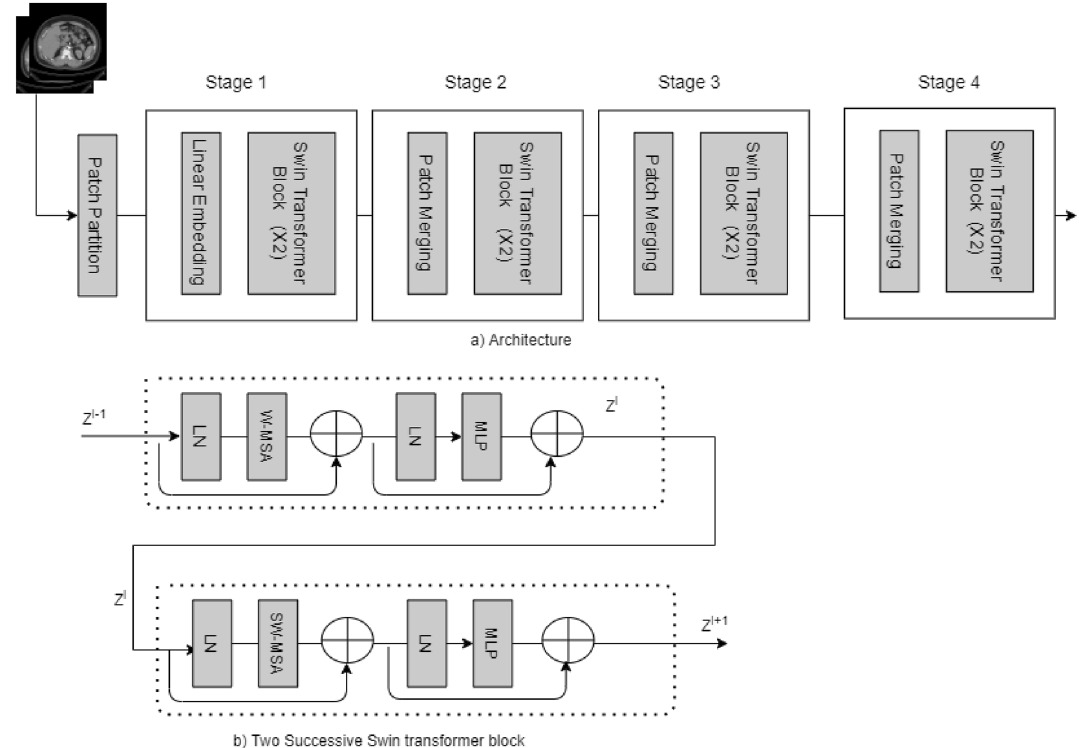
Figure 8. Shifted Window Transformer(Swin Transformer) diagram used in the